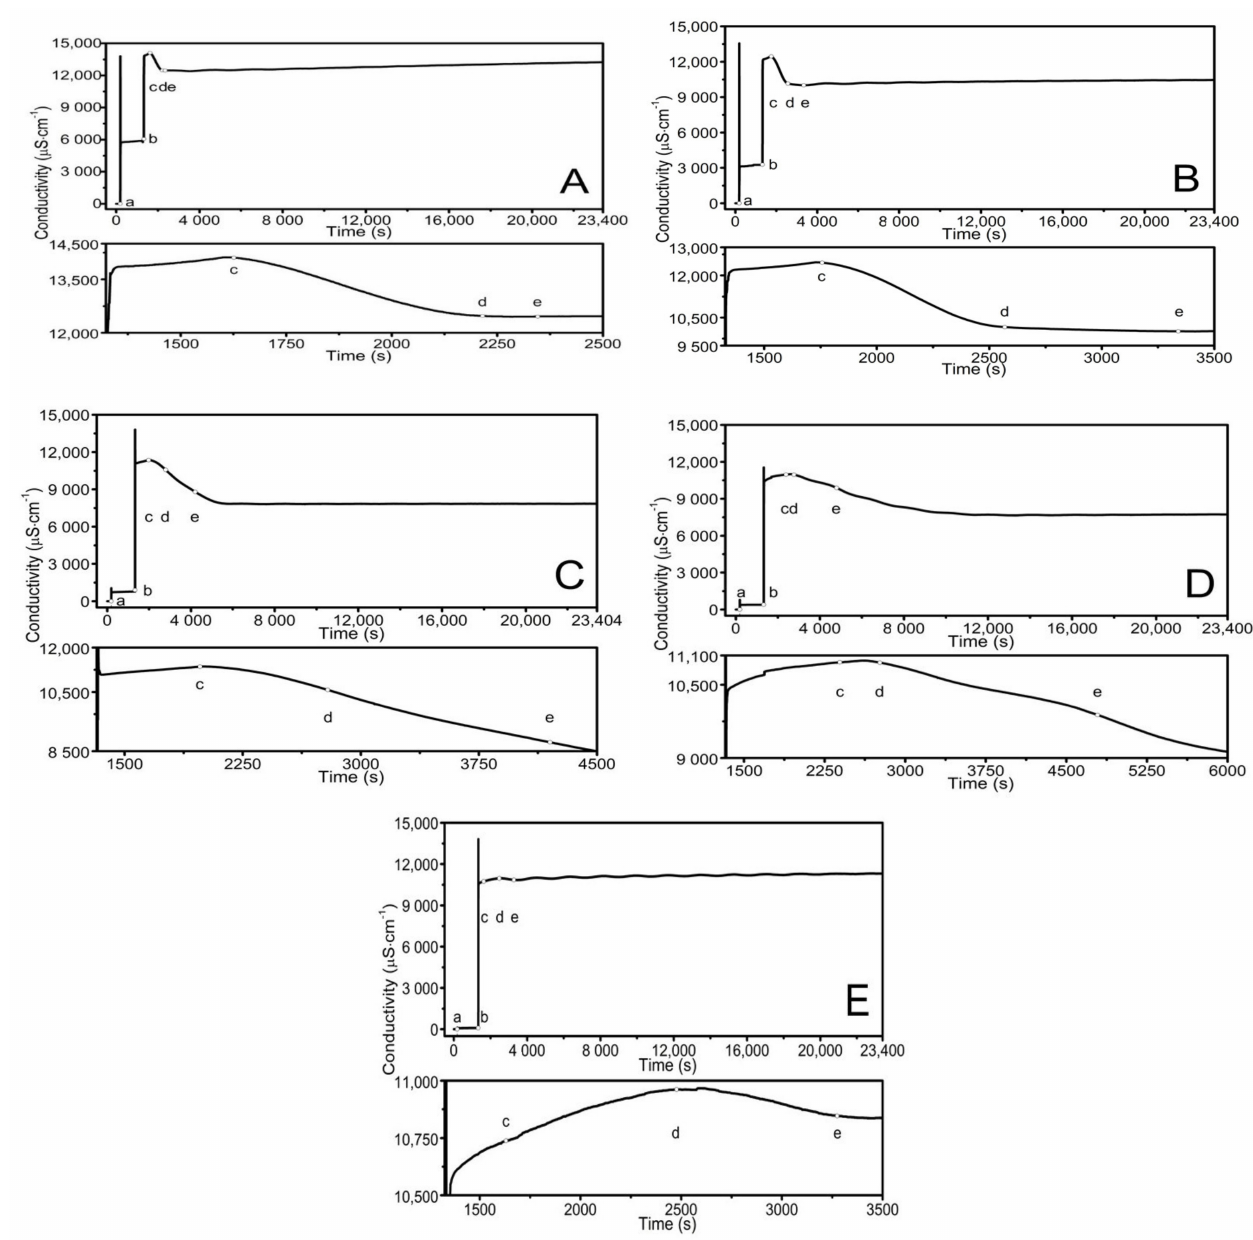
Figure 2. ( A – E ) Dependence of conductivity in the function of time in the reaction dispersion of PS1 ( A ), PS2 ( B ), PS3 ( C ), PS4 ( D ), and PS5 ( E ) in the course of the polymerization reaction at T = 70 ◦ C. Point (a) marks the addition of an initiator—KPS, point (b) the addition of the aqueous solution of the monomer—AMPSA, point (c) the visible change in color of the reaction mixture, point (d) indicates the decrease in color intensity, and point (e) total disappearance of yellow